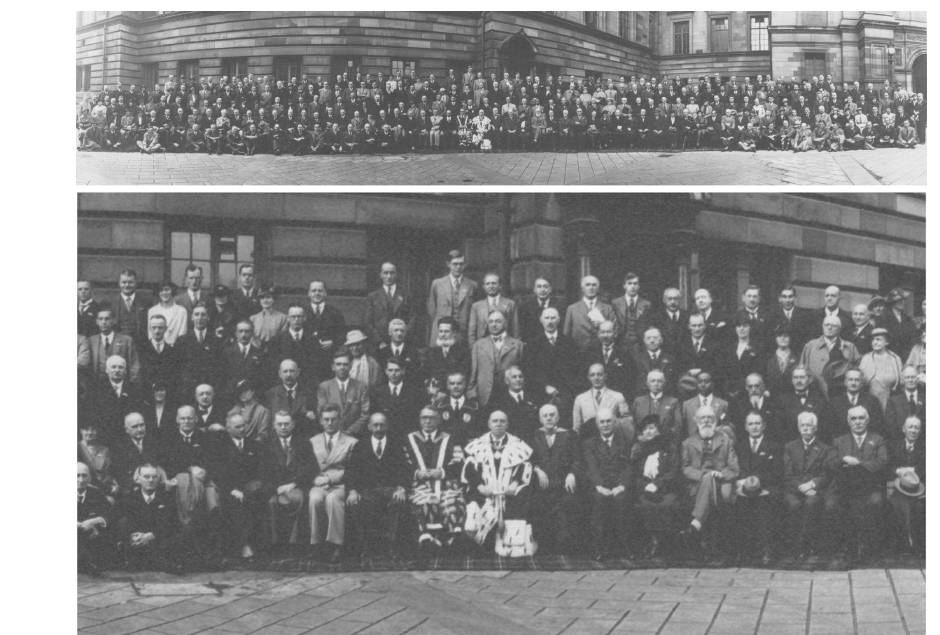
Figure 7. Participants of the VI General Assembly (upper panel); details of the central part of the photo (lower panel) (source: IUGG